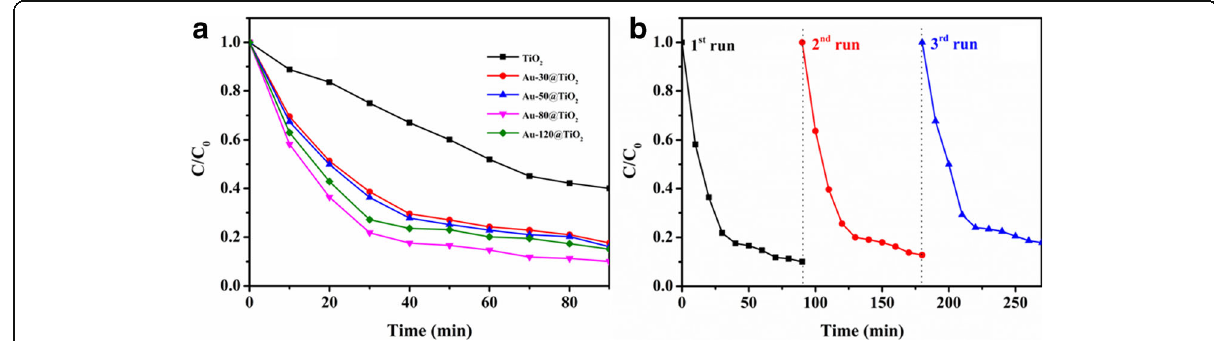
Fig. 6 a Evaluation of MB concentration versus reaction time in different conditions. b Recyclability of the photocatalytic degradation of